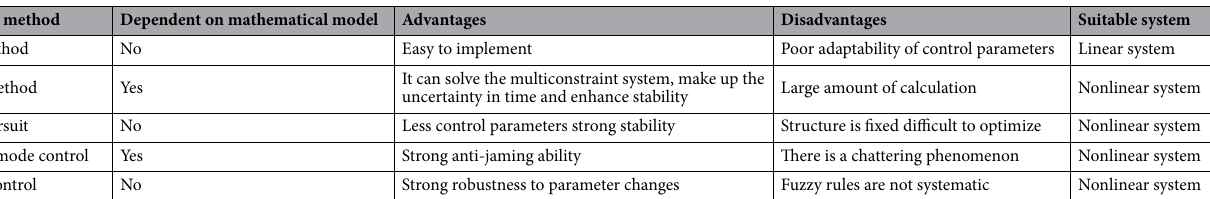
Table 1. Comparison of lateral tracking control methods.